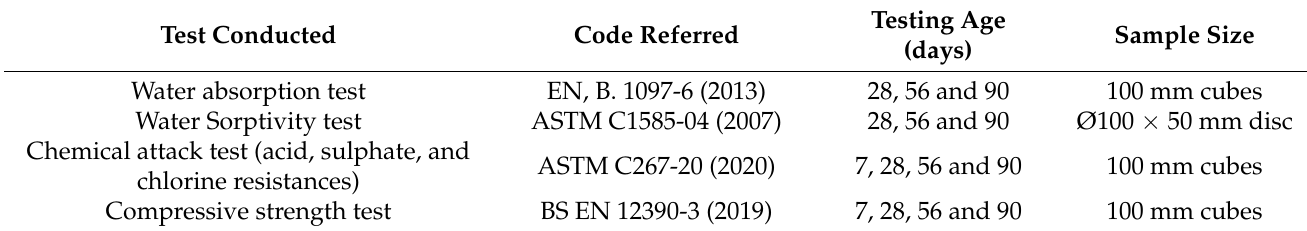
Table 2. Details of tests and the